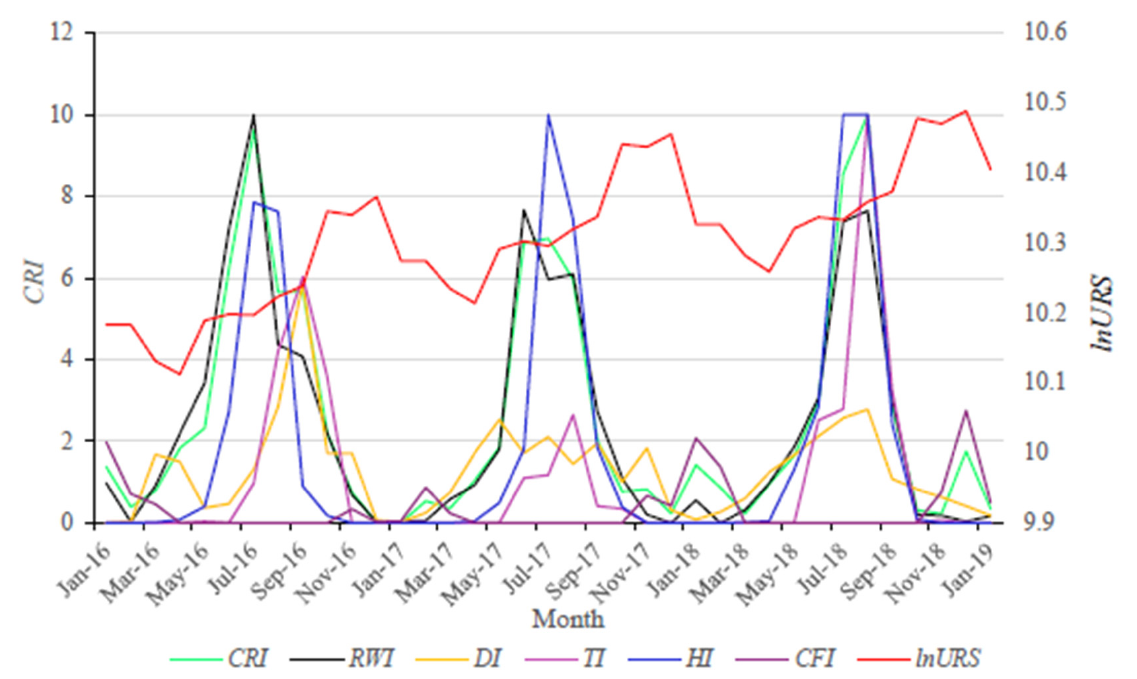
Figure 2. Monthly changes in residential consumption and comprehensive and subdivided climate risk index.